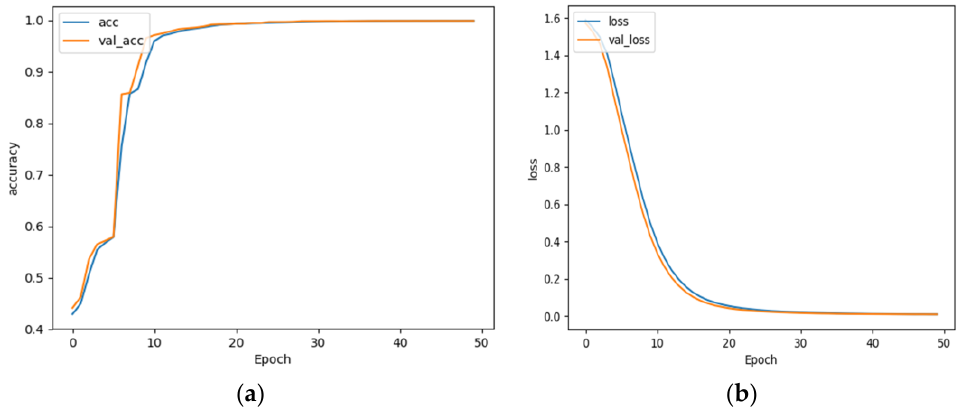
Figure 19. ( a ) Accuracy rate, ( b ) loss rate of the two-dimensional CNN for the packet feature model.